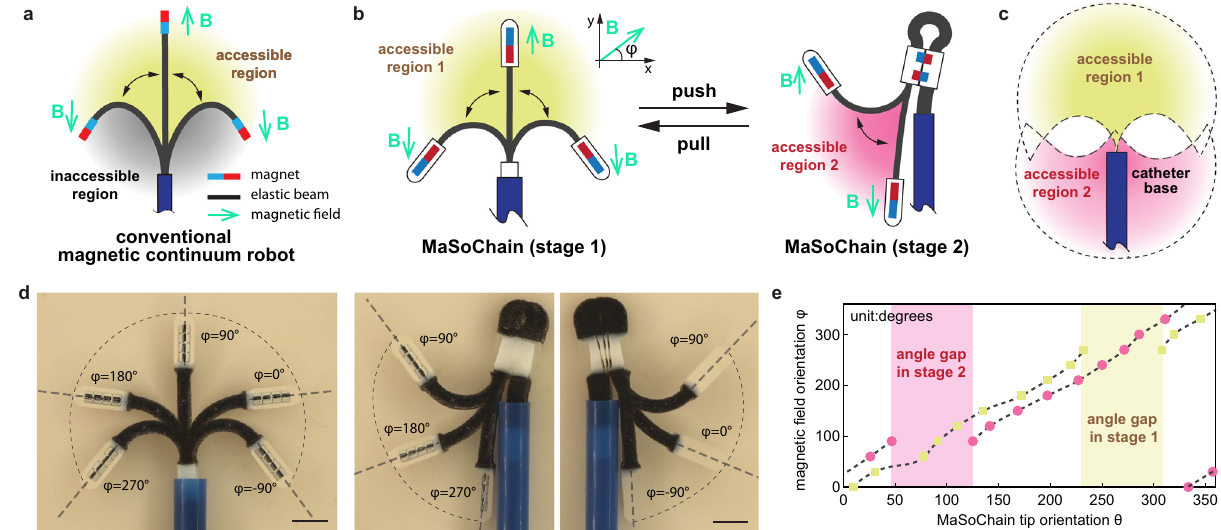
Fig. 4 | Expanded accessible regions for magnetically guided catheters. a A schematic illustration of a conventional magnetic continuum robot. Based on the reachable angles of the tip under a dynamic magnetic fi eld, we marked the sur- roundings as “ accessible region ” (in yellow) and “ inaccessible region ” (in black). b AccessibleregionsoftwostagesoftheMaSoChainbypushingandpullingrelative tothesheathingtube/catheter. c Theexperimentalresultsofoverlappedimagesof the catheter position, orientation (dashed straight line), and corresponding mag- netic fi eld orientation φ . The external magnetic fi eld is 10 mT rotating inside the